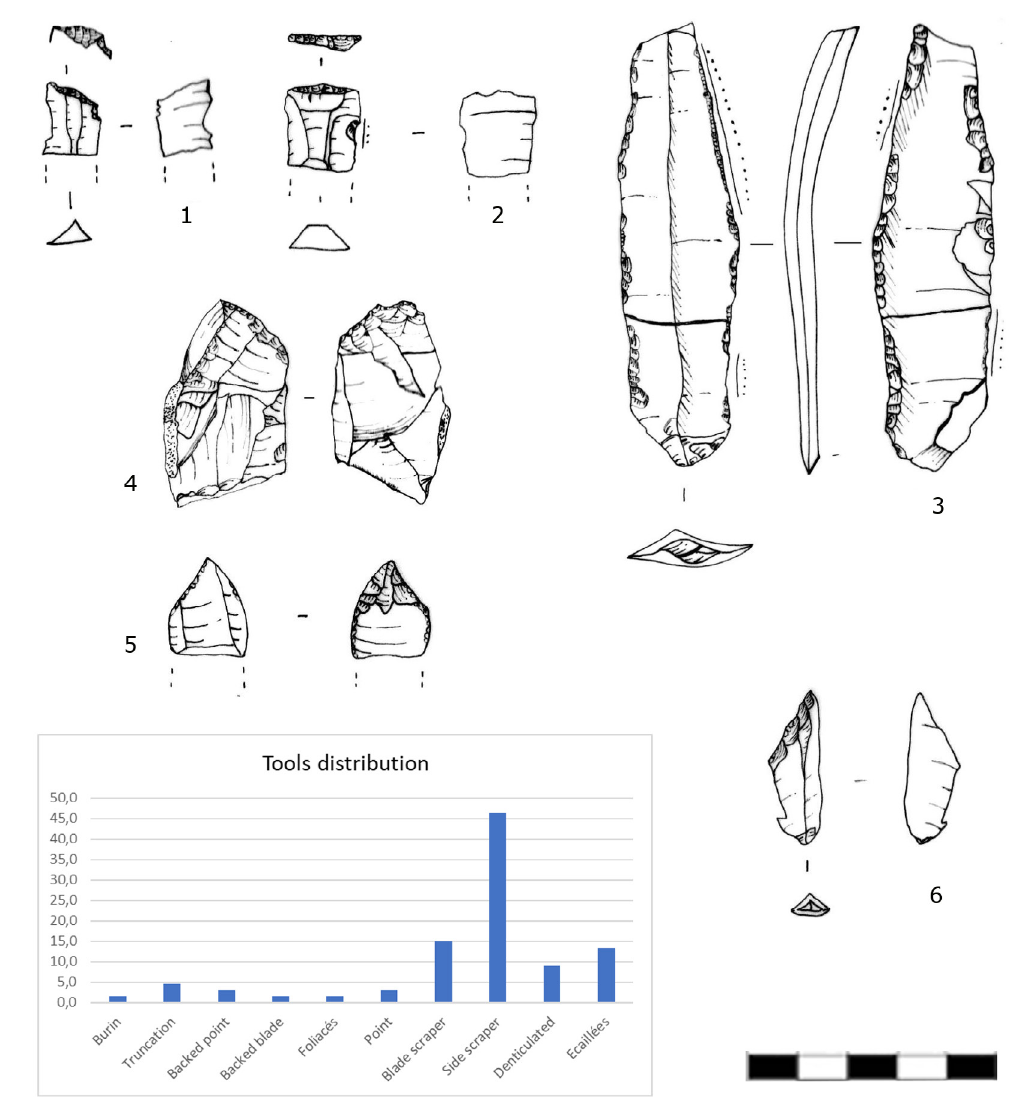
Figure 13. S. Martino. Tools from Diana occupation levels and